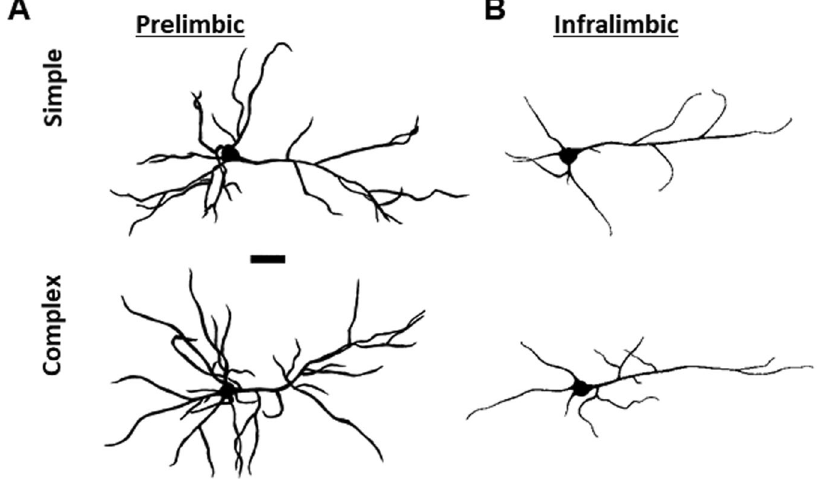
Figure 2. Representative dendritic profiles from animals reared in simple and complex environments. Scale bar = 100 µ